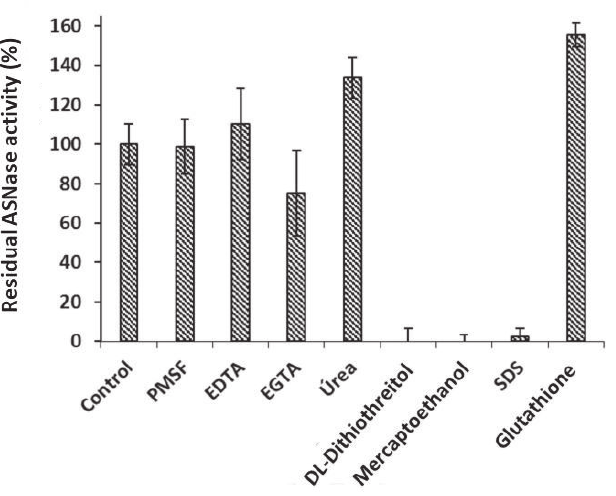
Fig. 5 – Effect of inhibitors on l -asparaginase from Entero- bacter sp. strain M55